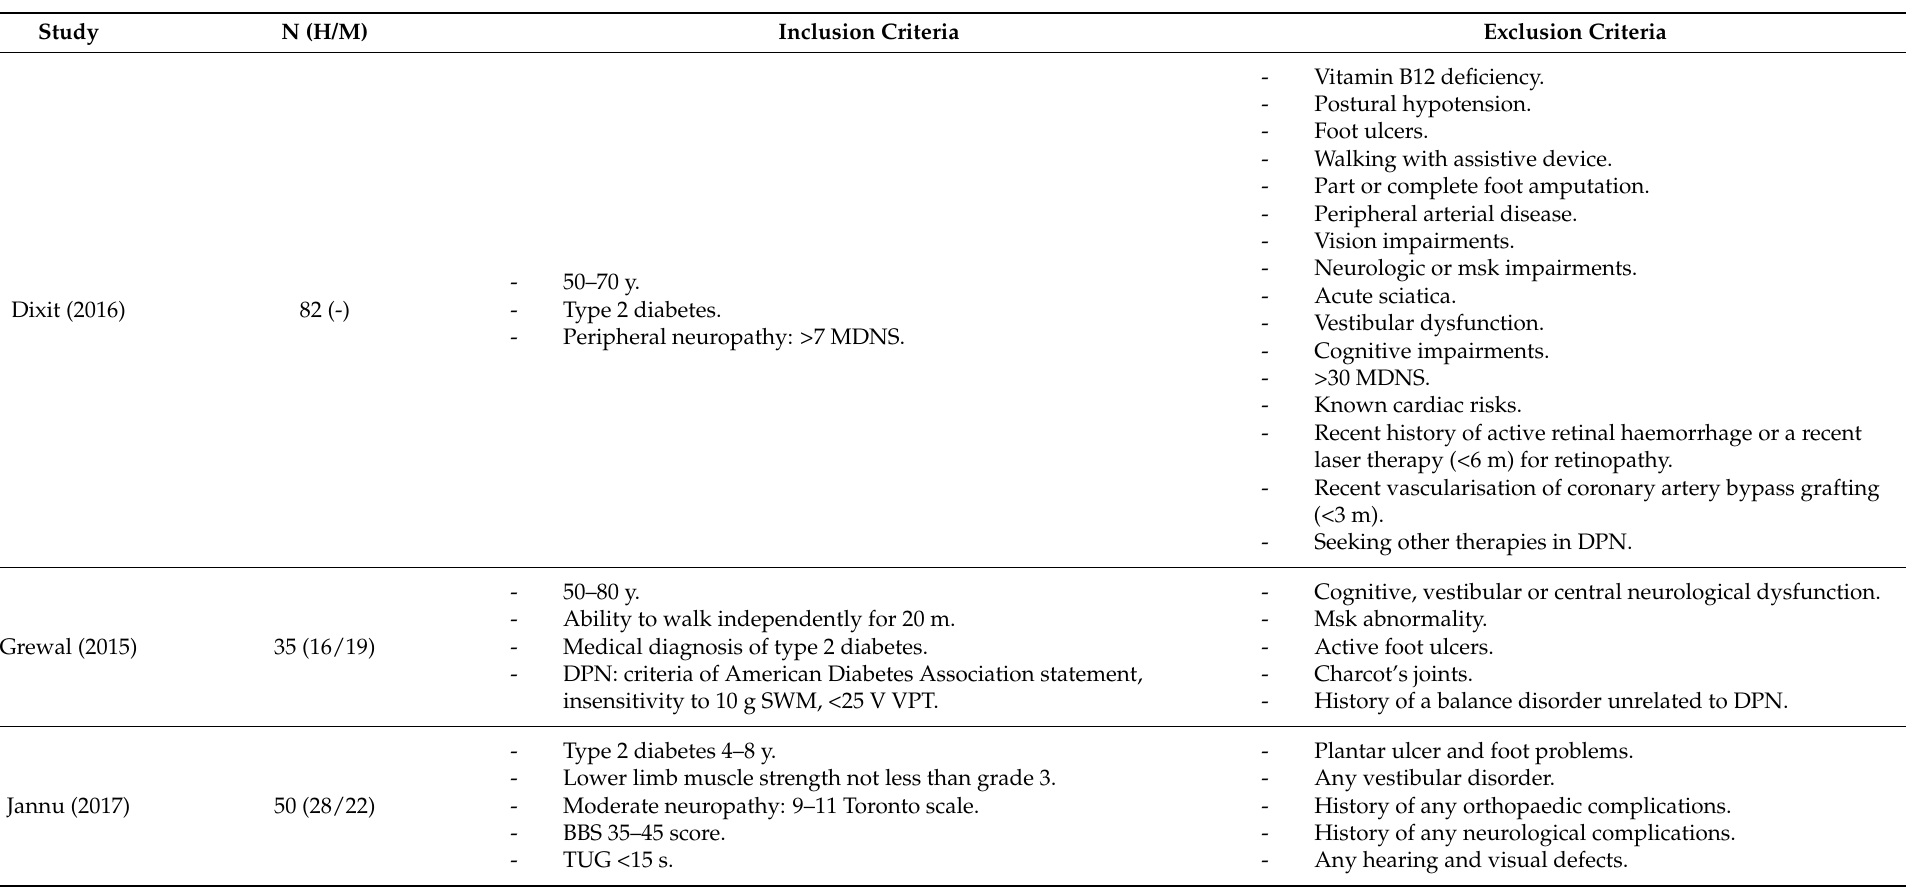
DPN: criteria of American Diabetes Association statement, insensitivity to 10 g SWM, <25 V